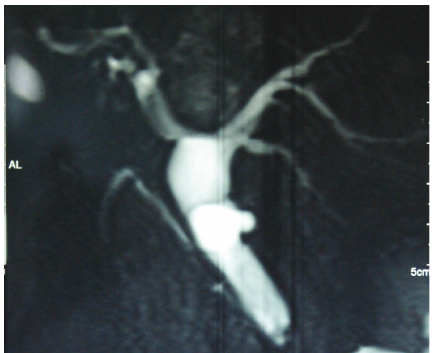
Figure 8: Follow up MRCP at 1 year showing absence of any filling defect in the left hepatic